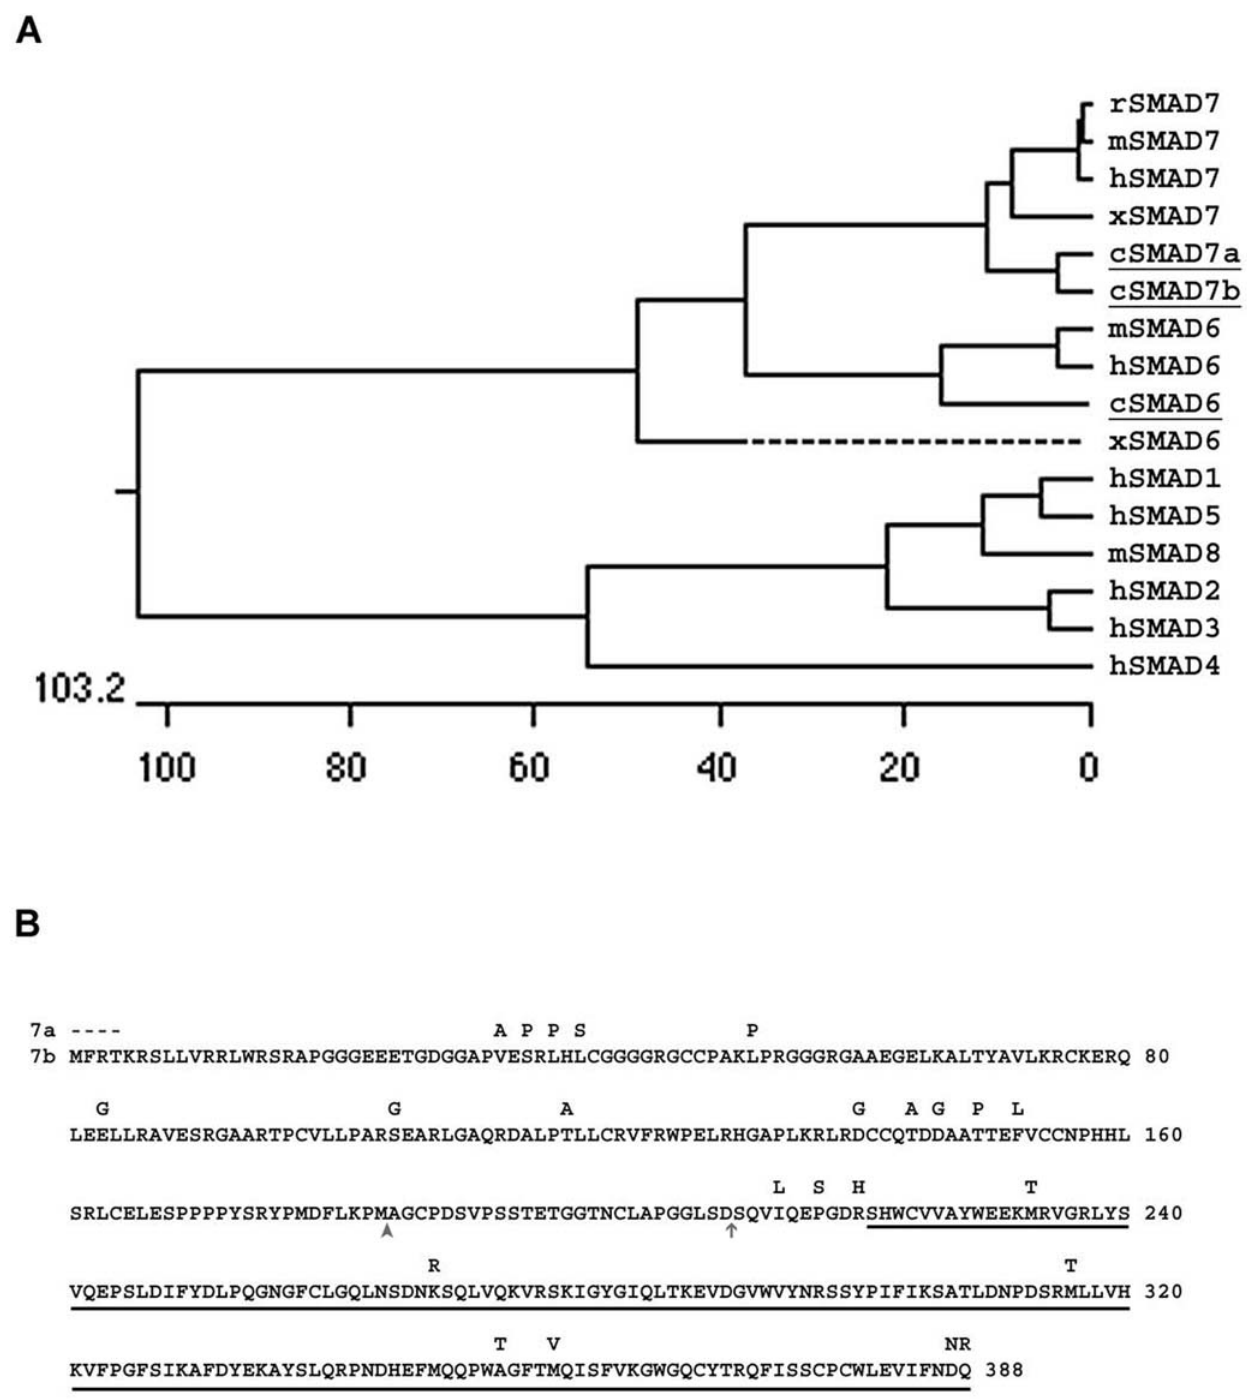
Figure 1. Chicken negative Smad genes. A. Phylogenetic relationship of chicken negative Smad proteins to other Smads. Conceptual translations of the chicken Smad6 , Smad7a and Smad7b gene open reading frames were compared to those of other vertebrate negative Smad, positive Smad and common Smad genes. The chick gene names are underlined. x: Xenopus , m: mouse, h: human, r: rat, c: chick. B. Comparison of cSmad7a (7a) and cSmad7b (7b) translated open reading frames. Blank positions in the cSmad7a sequence are identical to cSmad7b , dashes are absent and differences are indicated. Vertical arrowhead marks the beginning, and vertical arrow marks the end, of the translated sequence conserved between cSmad7a and genomic contig NW_001482773.1. The vertical arrow marks the beginning of the translated sequence conserved between cSmad7a and the genomic cSmad7 locus on the Z chromosome. Underline indicates the MH2 domain that is conserved amongst all Smad proteins. Note absence of serine residues among last four amino acids.